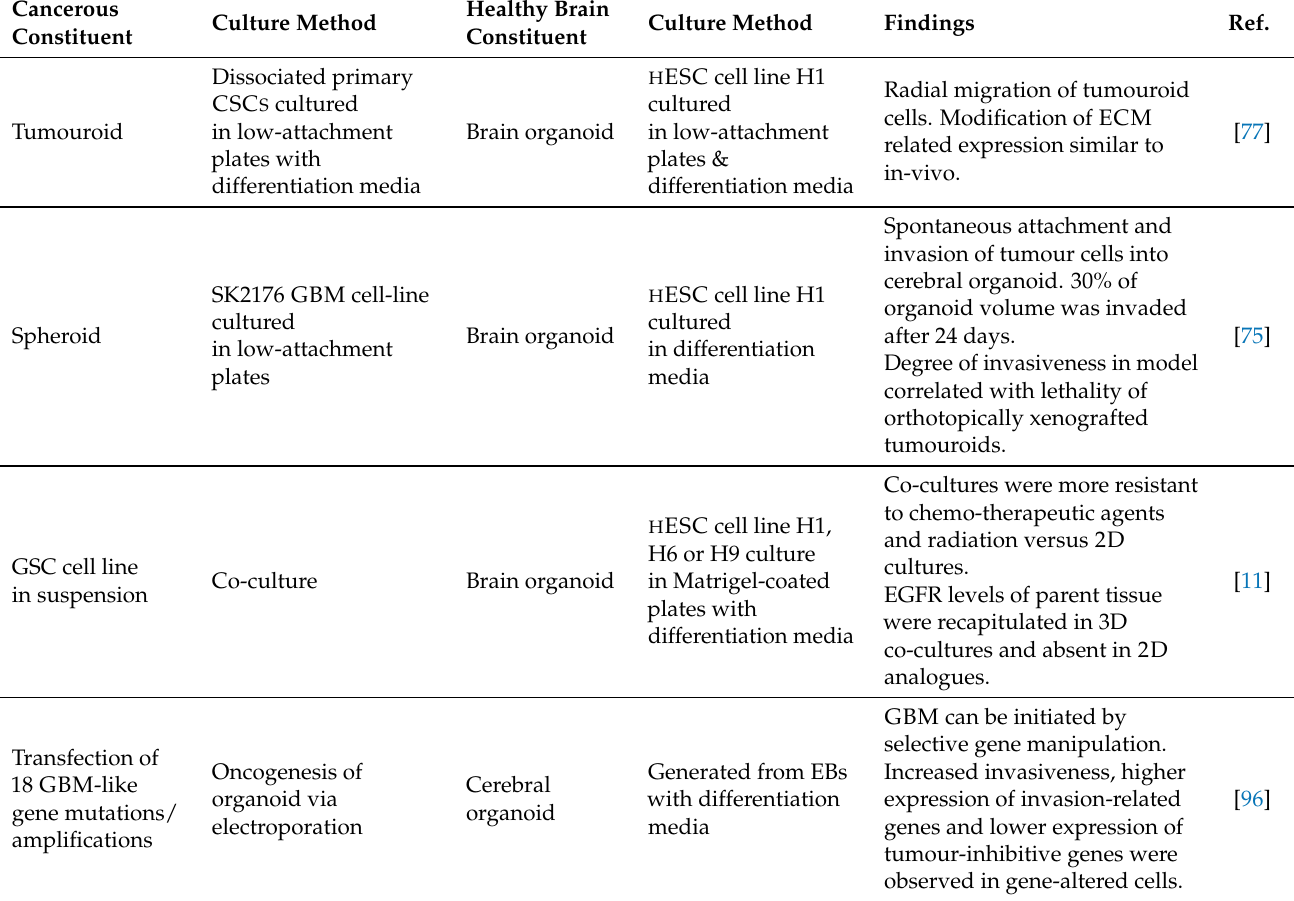
Table 6. Key methods for the formation of co-culture models from various combinations of tumouroid/spheroid/organoid and the findings generated with their